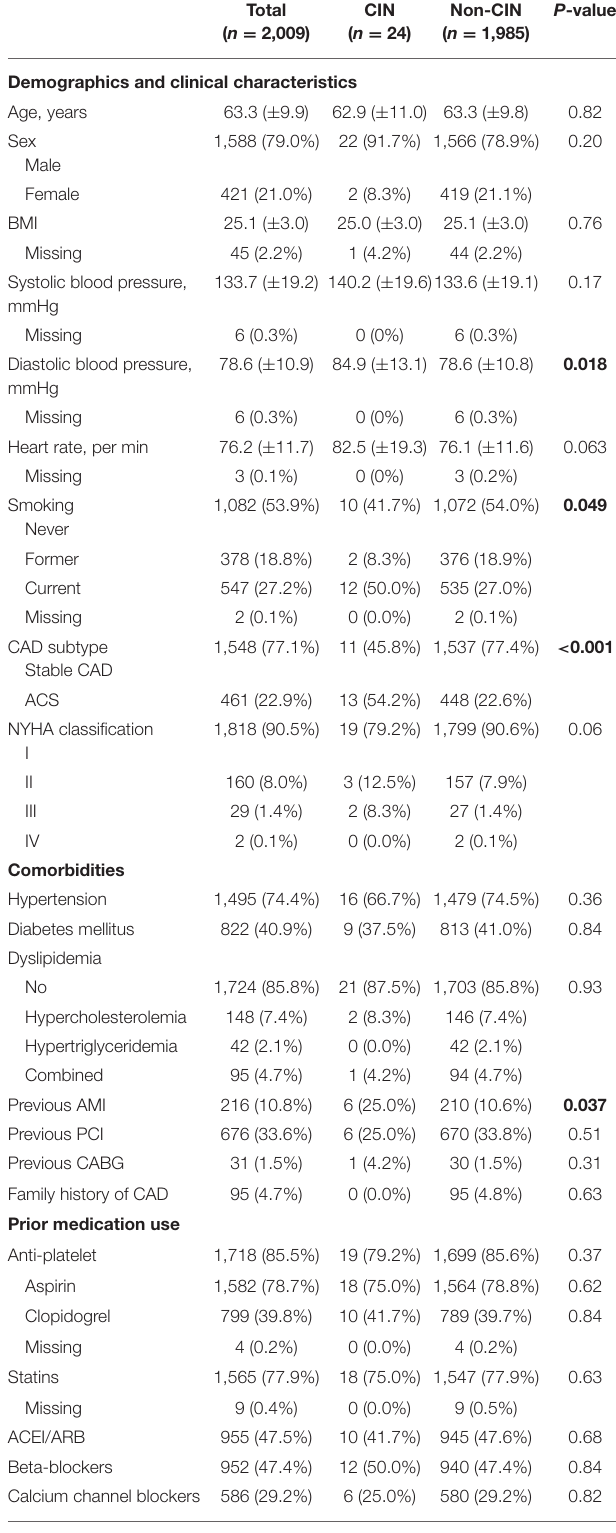
TABLE 1 | Basic characteristics of the CIN and non-CIN